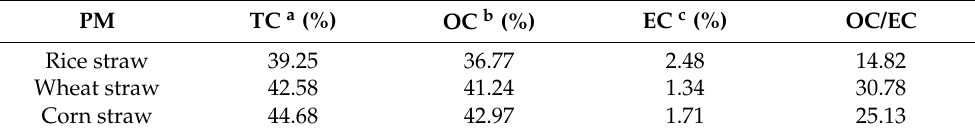
Table 4. Contents of TC, OC, EC and OC/EC ratios in PM of crop straws.